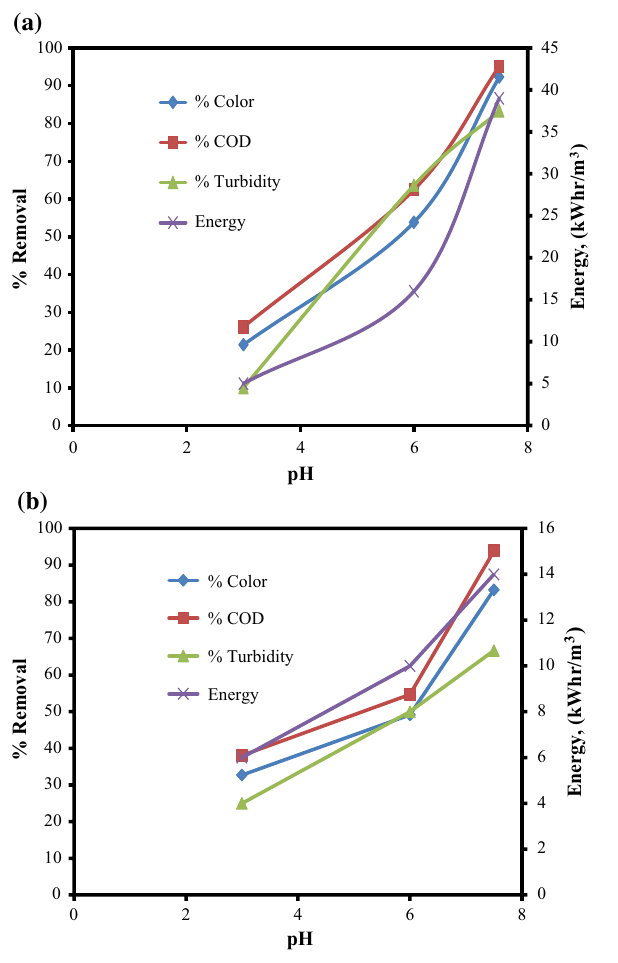
Fig. 2 Removal efficiency and power consumption versus pH on a Al and b Fe